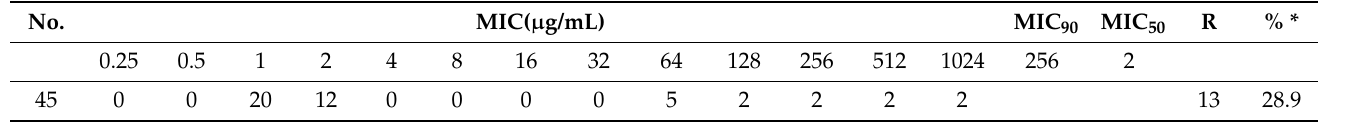
Table 3. Distribution of MIC, MIC 90 , and MIC 50 of imipenem among the isolated P. aeruginosa . No.